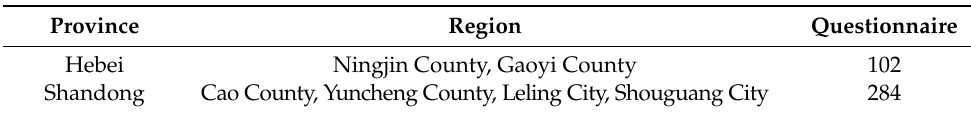
Table 1. Number of questionnaires by